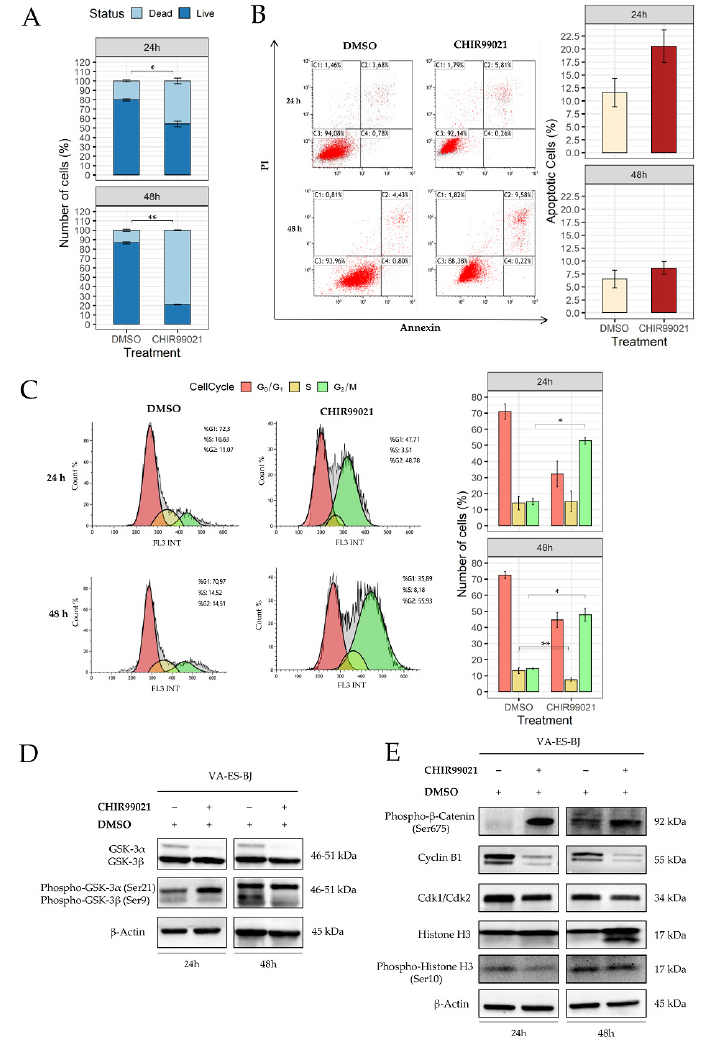
Figure 4. CHIR99021 affects the proliferation of as ES cell line. ( A ) CHIR99021’s effect on the viability of the VA-ES-BJ cell line evaluated using a trypan blue exclusion assay. Cell line was exposed to 100 µ M for 24 and 48 h. Cell viability is presented as percentages distinguishing dead cells (light blue) from live cells (blue). The graph represents means ± SE of three independent experiments; differences between treatments groups were estimated by paired t tests. ( B ) Dot plot diagrams following 24 and 48 h treatments of VA-ES-BJ cells with CHIR99021 analysed by FACS, after Annexin V-FITC and PI labelling. Representative dot plots present intact cells in the lower-left quadrant, early apoptotic cells in the lower-right quadrant, late apoptotic or necrotic cells in the upper-right quadrant and necrotic cells in the upper-left quadrant. Histogram reported the mean ± SE of apoptotic cell percentage from three separate experiments. ( C ) Representative plots of DNA content distribution of cell cycle phases of VA-ES-BJ cell treated with CHIR99021 100 µ M for 24 and 48 h. Histogram represents the percentage of cell number in the G 0 /G 1 , S, and G 2 /M phases after treatment. The values are representative of means ± SE of three separate experiments using paired t tests (*: p < 0.05; **: p < 0.001). ( D ) Western blot analysis showing the expression of GSK-3 α / β and p -GSK-3 α / β proteins in VA-ES-BJ cell after treatment with CHIR99021 or vehicle for 24 and 48 h. The same blot was reprobed with anti- β -Actin to confirm the equal loading of each lane (40 µ g of whole lysate). ( E ) Western blot analysis reported the expression levels of protein related to cell cycle signals at 24 and 48 h after CHIR99021 100 µ M treatment. The blot was first incubated with anti-Cdk1/Cdk2, anti-CyclinB1, anti-phospho-HistoneH3, anti-HistoneH3, anti-phospho- β -Catenin and then reprobed with anti- β -Actin to confirm the equal loading of each lane (40 µ g of whole